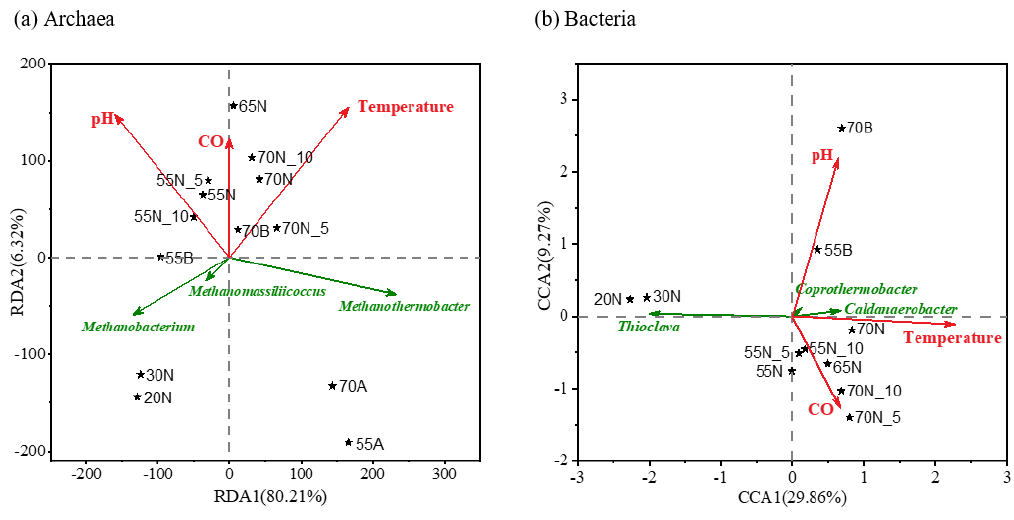
Figure 3. Redundancy analysis (RDA) and canonical correlation analysis (CCA) of microbial communities related to environmental variables: ( a ) archaeal community; ( b ) bacterial community. Nodes: hydrogenotrophic methanogenic mixed culture samples; red arrows: environmental variables; green arrows: functional microbes.